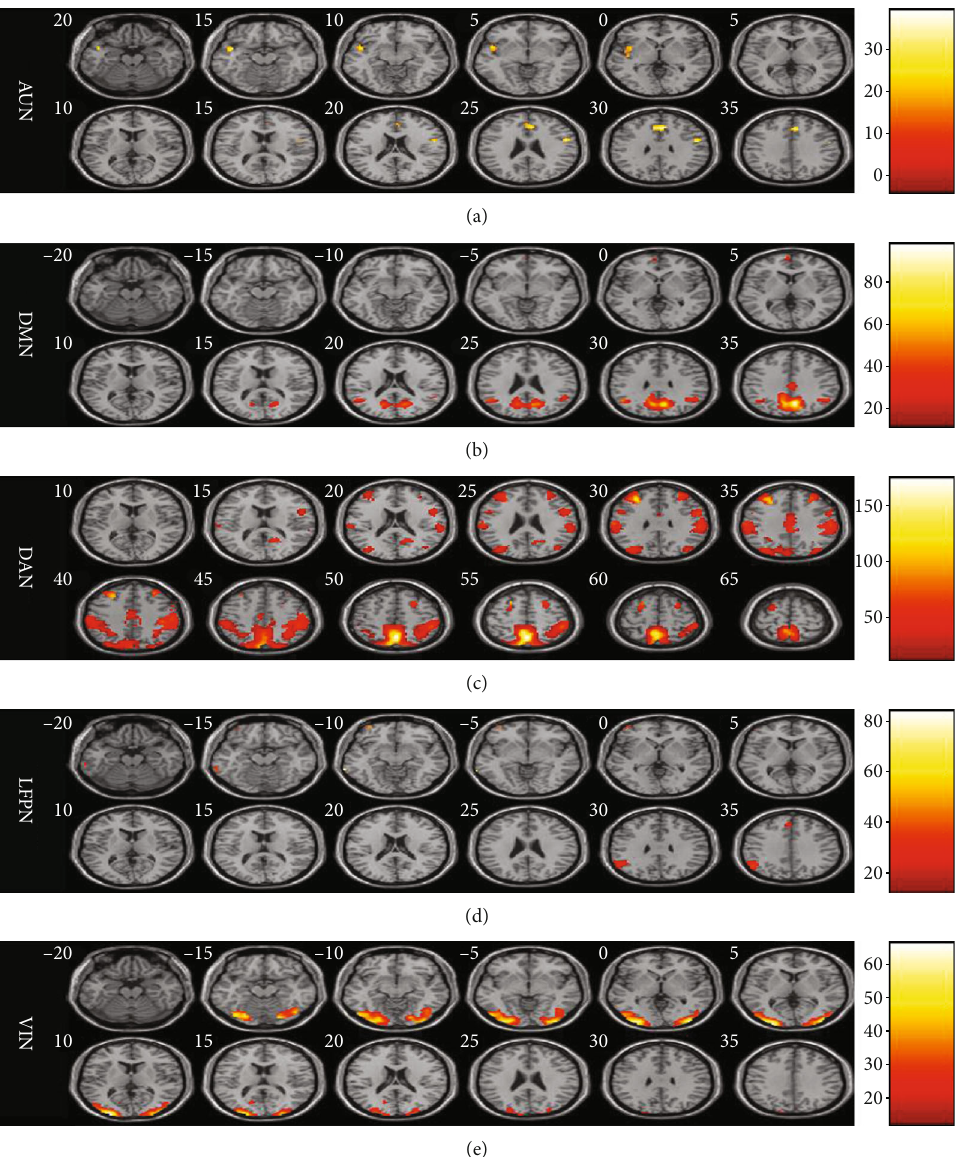
Figure 2: Aberrant functional connectivity in the AUN, DMN, DAN, LFPN, and VIN among the three groups. (a – e) Statistical maps for the AUN, DMN, DAN, LFPN, and VIN among the three groups. AUN: auditory network; DMN: default mode network; DAN: dorsal attention network; LFPN: left frontoparietal network; RFPN: right frontoparietal network; VIN: visual